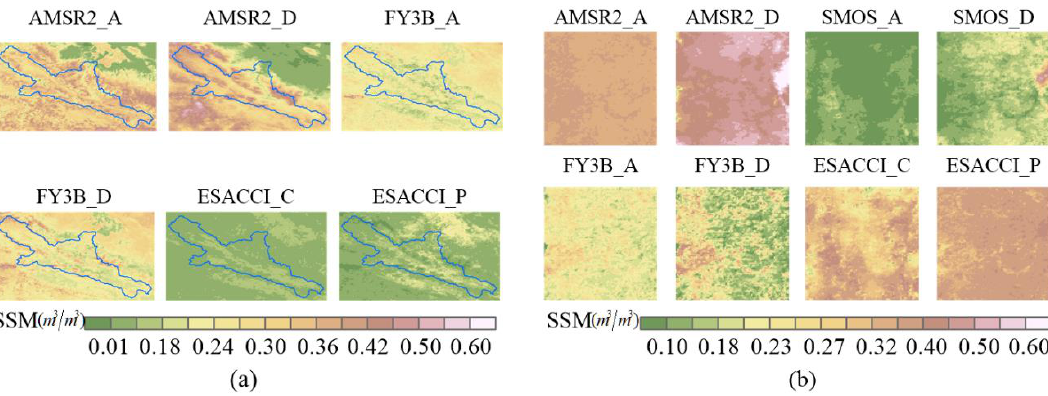
Figure 5. One kilometer trend predictions of GWATPRK from different coarse SSM products in two experimental regions. ( a ) Upper HBR area on August 14 2012, and ( b ) Naqu area on 13 August 2012.